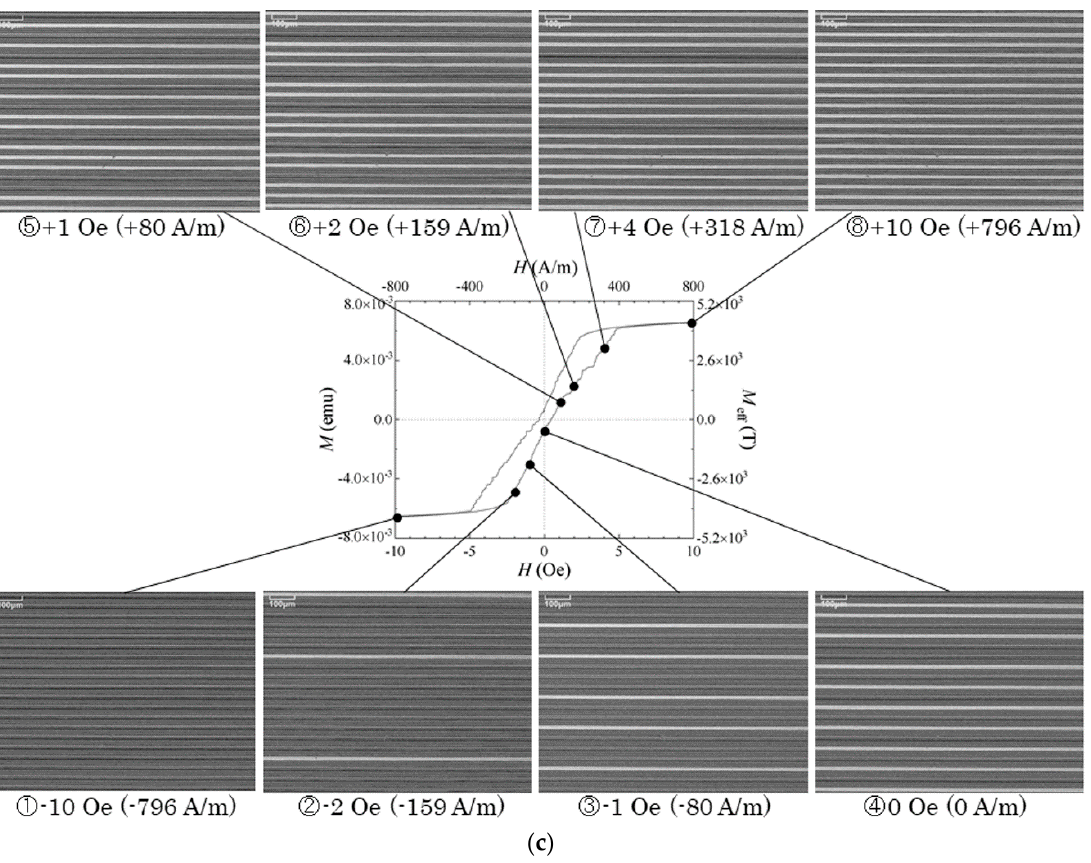
Figure 9. MH-loop and corresponding photo of the magnetic domain. ( a ) The case for easy axis θ = 61 ° . ( b ) The case for easy axis θ = 71 ° . ( c ) The case for easy axis θ = 90 ° .